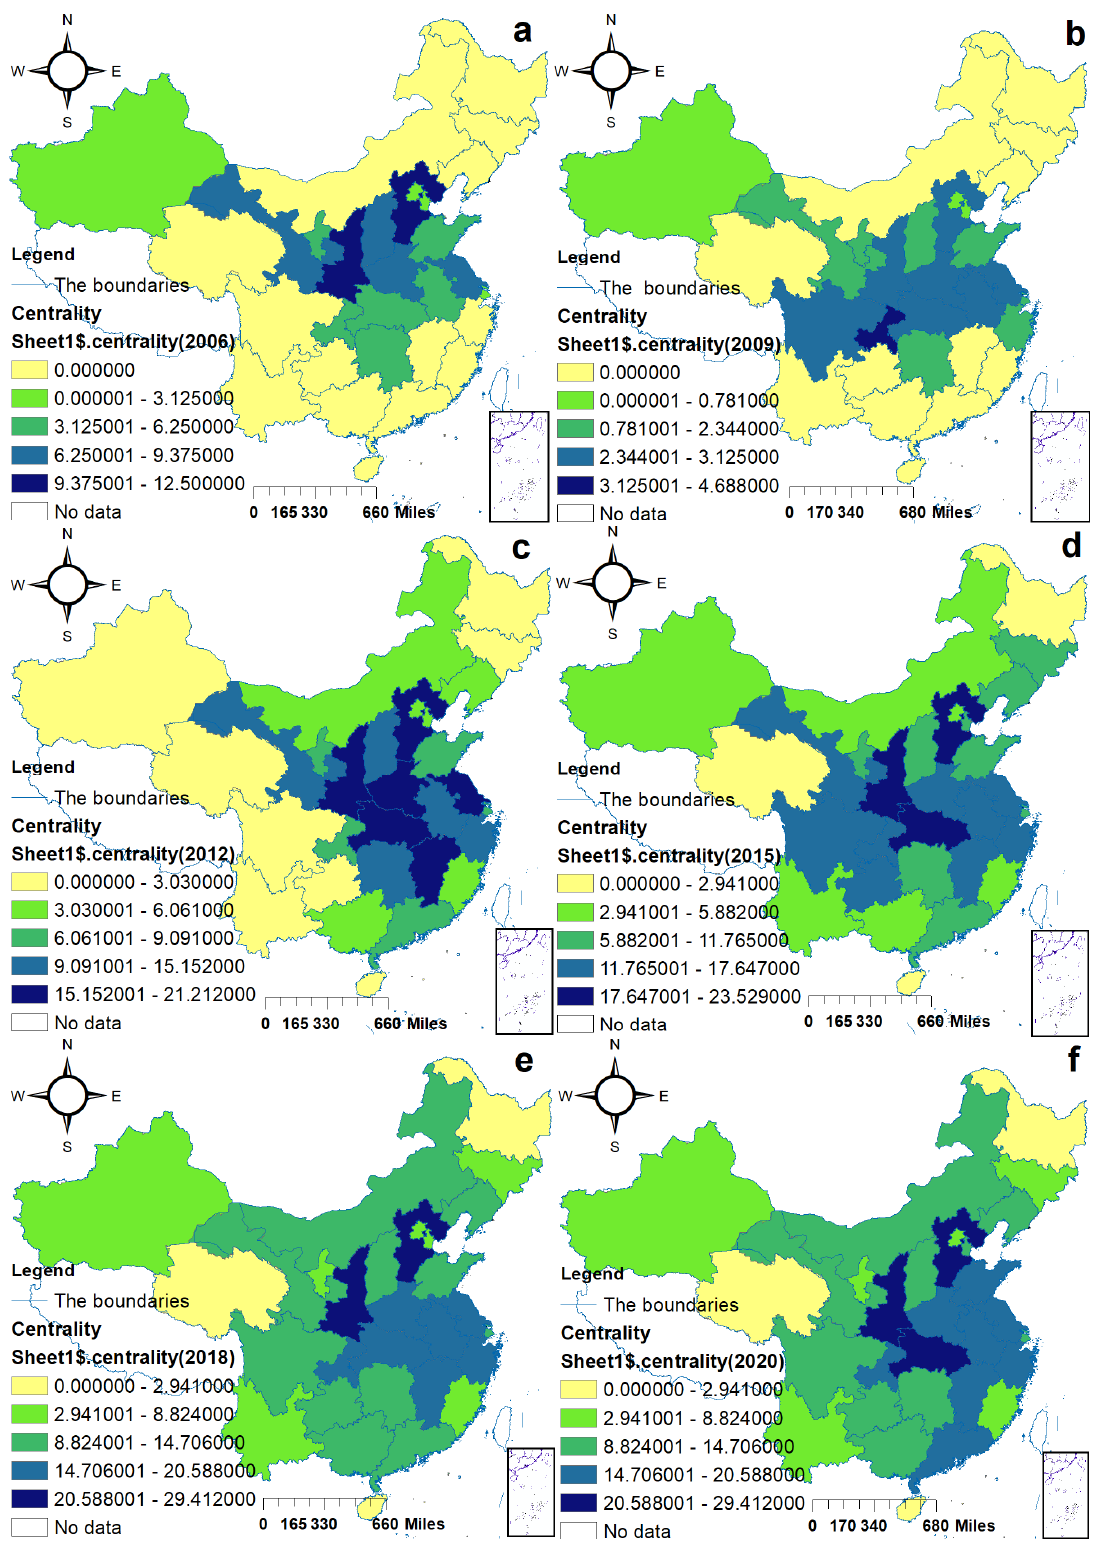
Figure 2. Spatial evolution characteristics of natural gas supply chain length. Notes: Figures ( a ), ( b ), ( c ), ( d ), ( e ) and ( f ) represent the centrality of the length of the natural gas energy supply chain in 2006, 2009, 2012, 2015, 2018, and 2020, respectively. The figures were created by the author using ArcGis 10.8.